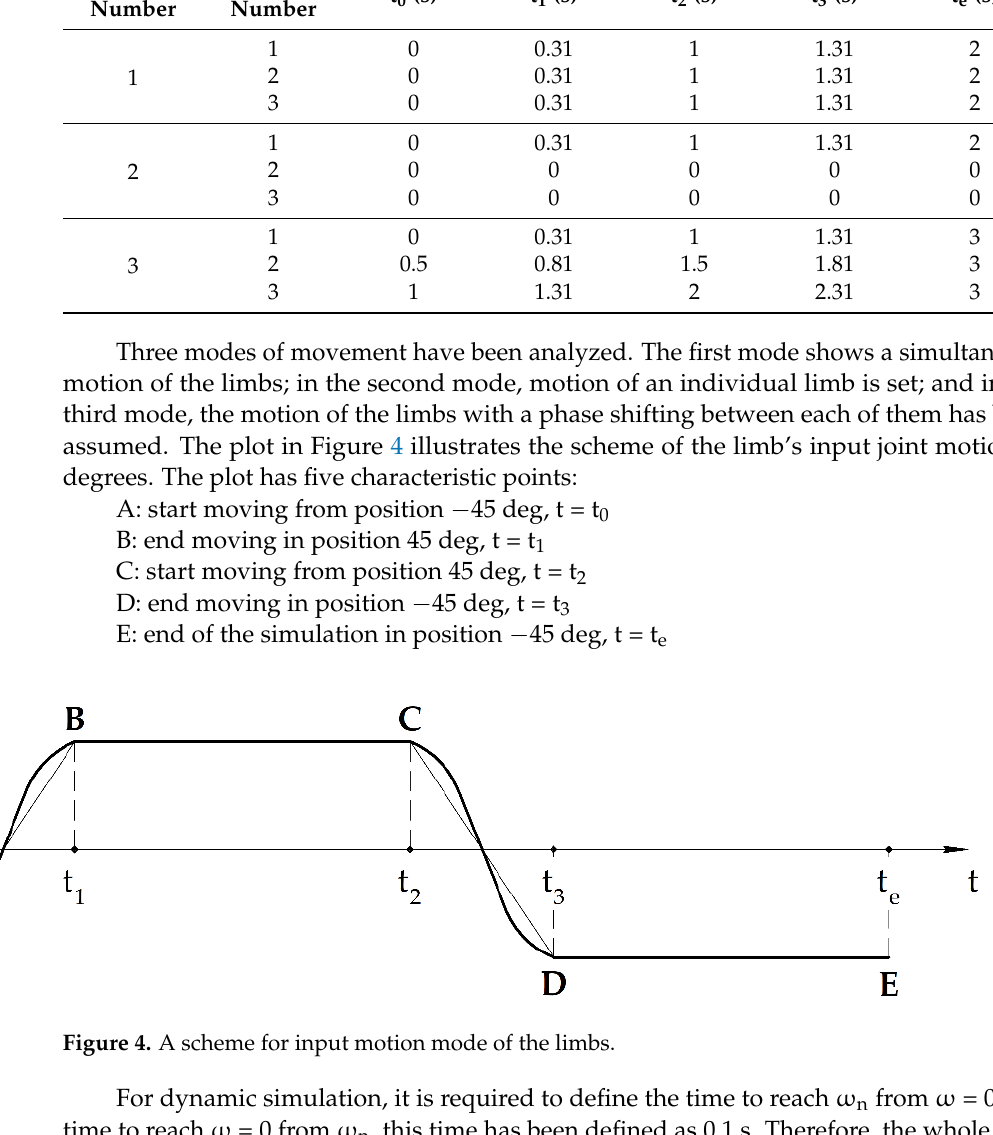
Table 3. Time data for limbs input joint motion in dynamic simulation, Figure 4 Mode